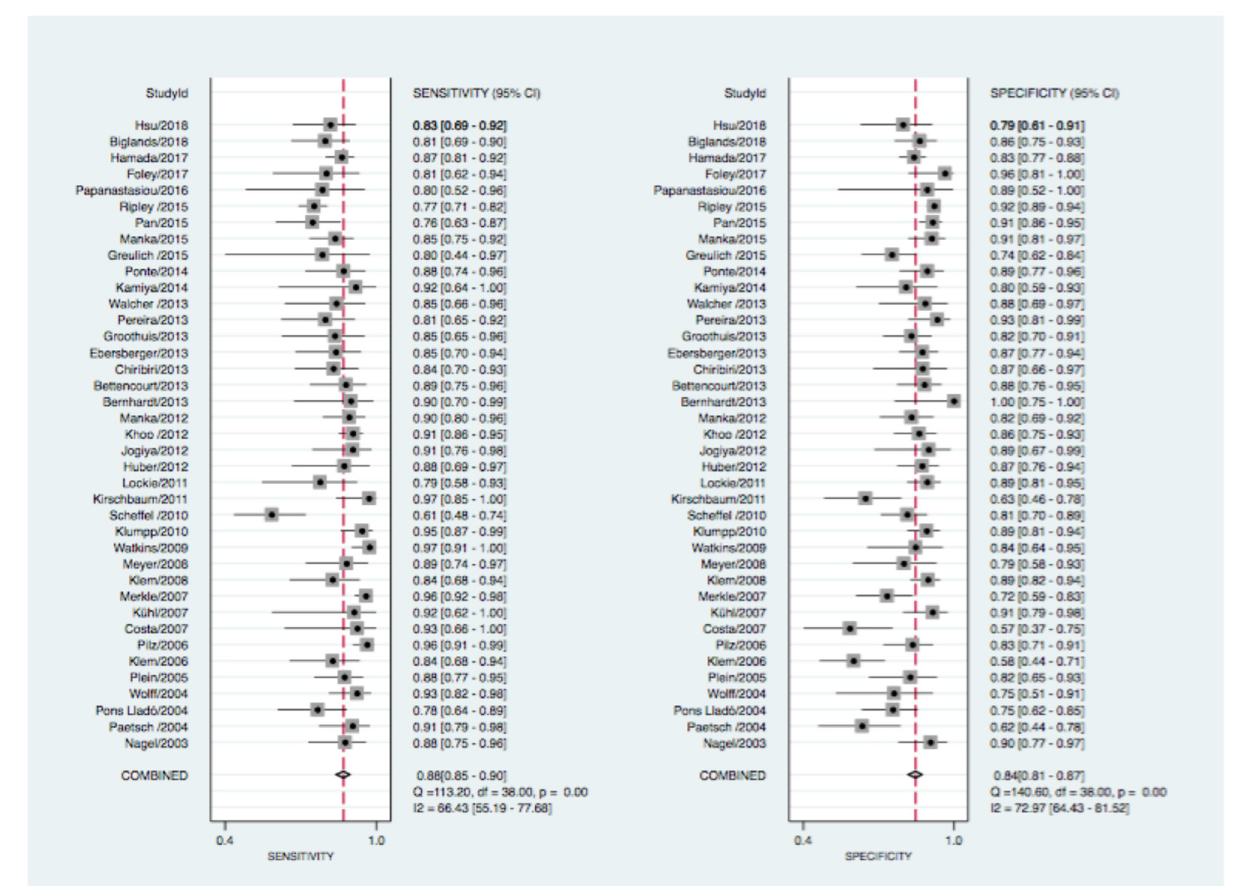
FIGURE 2 | Forrest plot for pCMR with sensitivity (left) and specificity (right) estimates. CI, confidence intervall; I 2 , the percentage of variation across studies that is due to heterogeneity rather than chance; Q, Cochran’s Q measure of